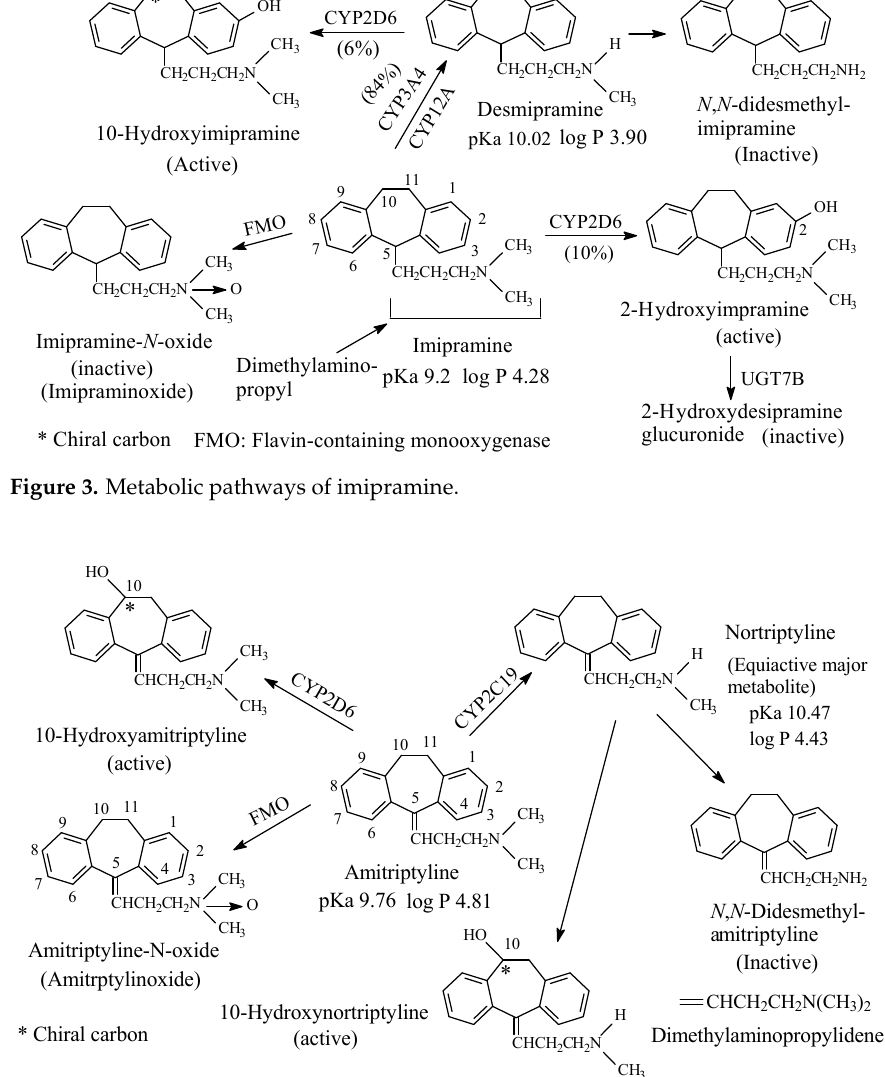
Figure 4. Metabolic pathways of amitriptyline. The four tricyclic antidepressant drugs are SNRI with imipramine and amitriptyline being more active as SRIs than NRIs and desmipramine and nortriptyline being more ac- tive as NRIs than SRIs [10]. Another metabolic pathway of imipramine and amitriptyline is N -oxygenation resulting in the formation of imipramine- N -oxide and amitriptyline- N - oxide, respectively. The two N -oxide metabolites have been developed as prodrugs of im- ipramine and amitriptyline since they (the N -oxide metabolites) are bioreduced in vivo to the tertiary amine parent drugs, imipramine and amitriptyline [11]. Reporting on comparison between imipramine and desmipramine, Rose and